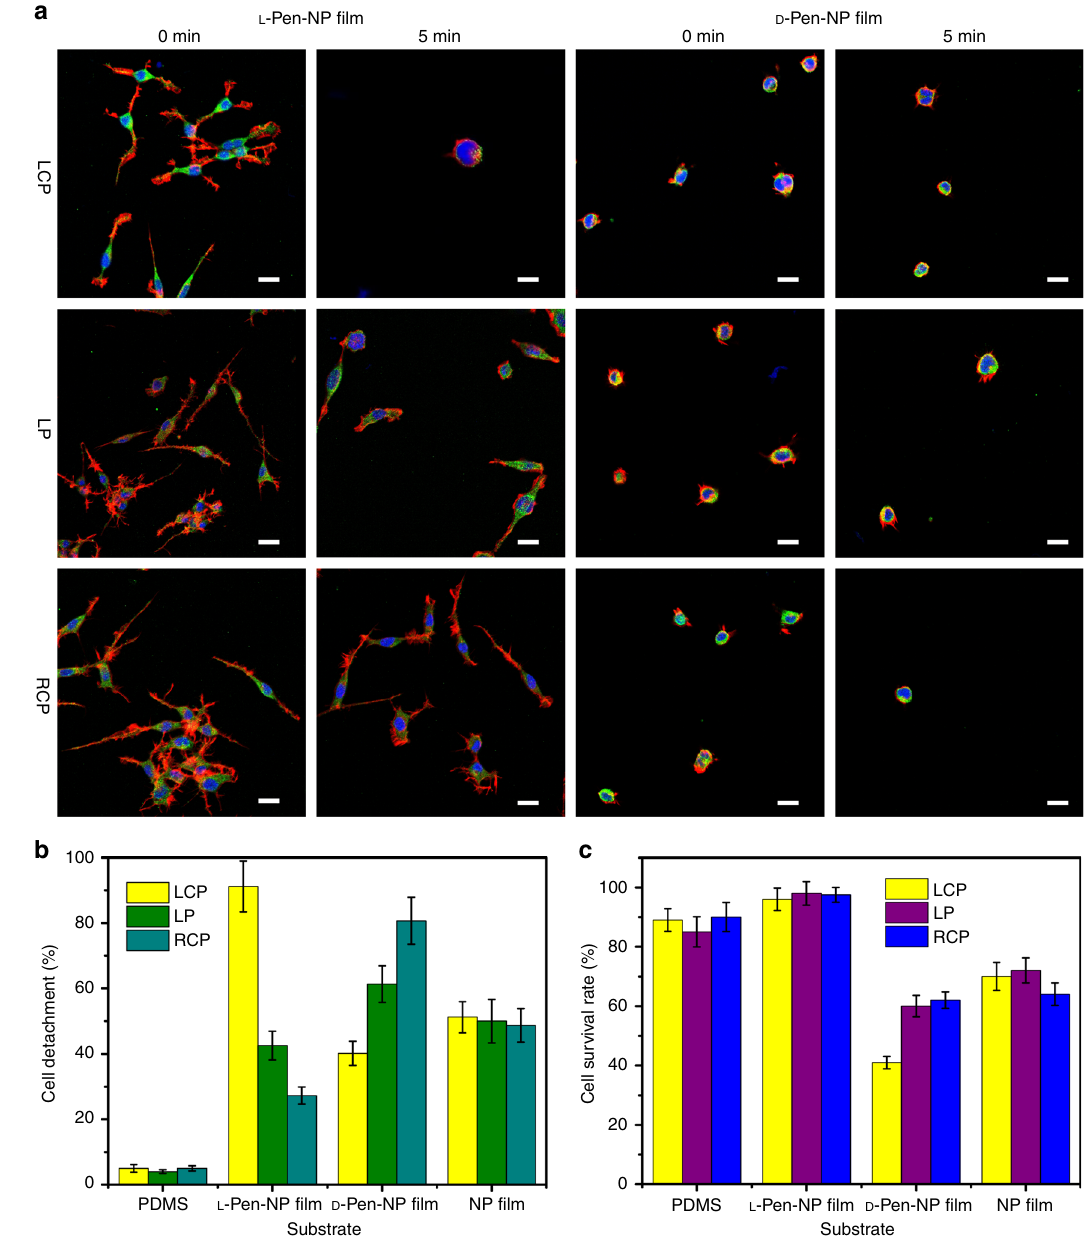
Fig. 5 Circularly polarized light triggered NG108-15 cells detachment. a Confocal images of NG108-15 cell grown on L / D - P en-NP fi lm upon polarized light irradiation (808 nm laser, 150 mW/cm 2 ). Scale bar, 20 μ m. b Cell detachment rates upon laser irradiation. c Cell survival rates of NG108-15 cells measured by live/dead assay. The error bars correspond to the standard error of the mean ( n = 3). LCP left circularly polarized light, LP linearly polarized light, RCP right circularly polarized